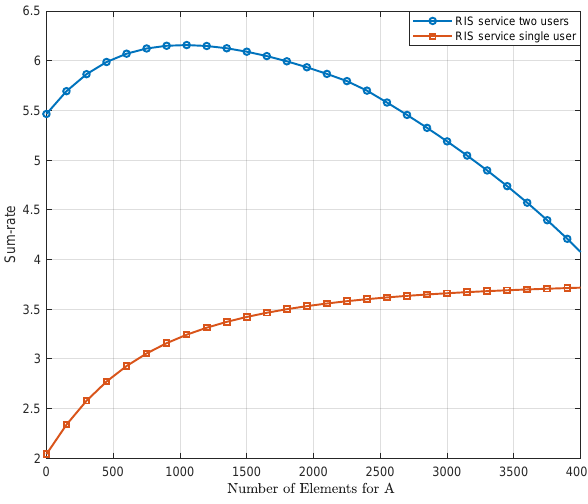
Figure 6. The relationship between the RIS service user number and